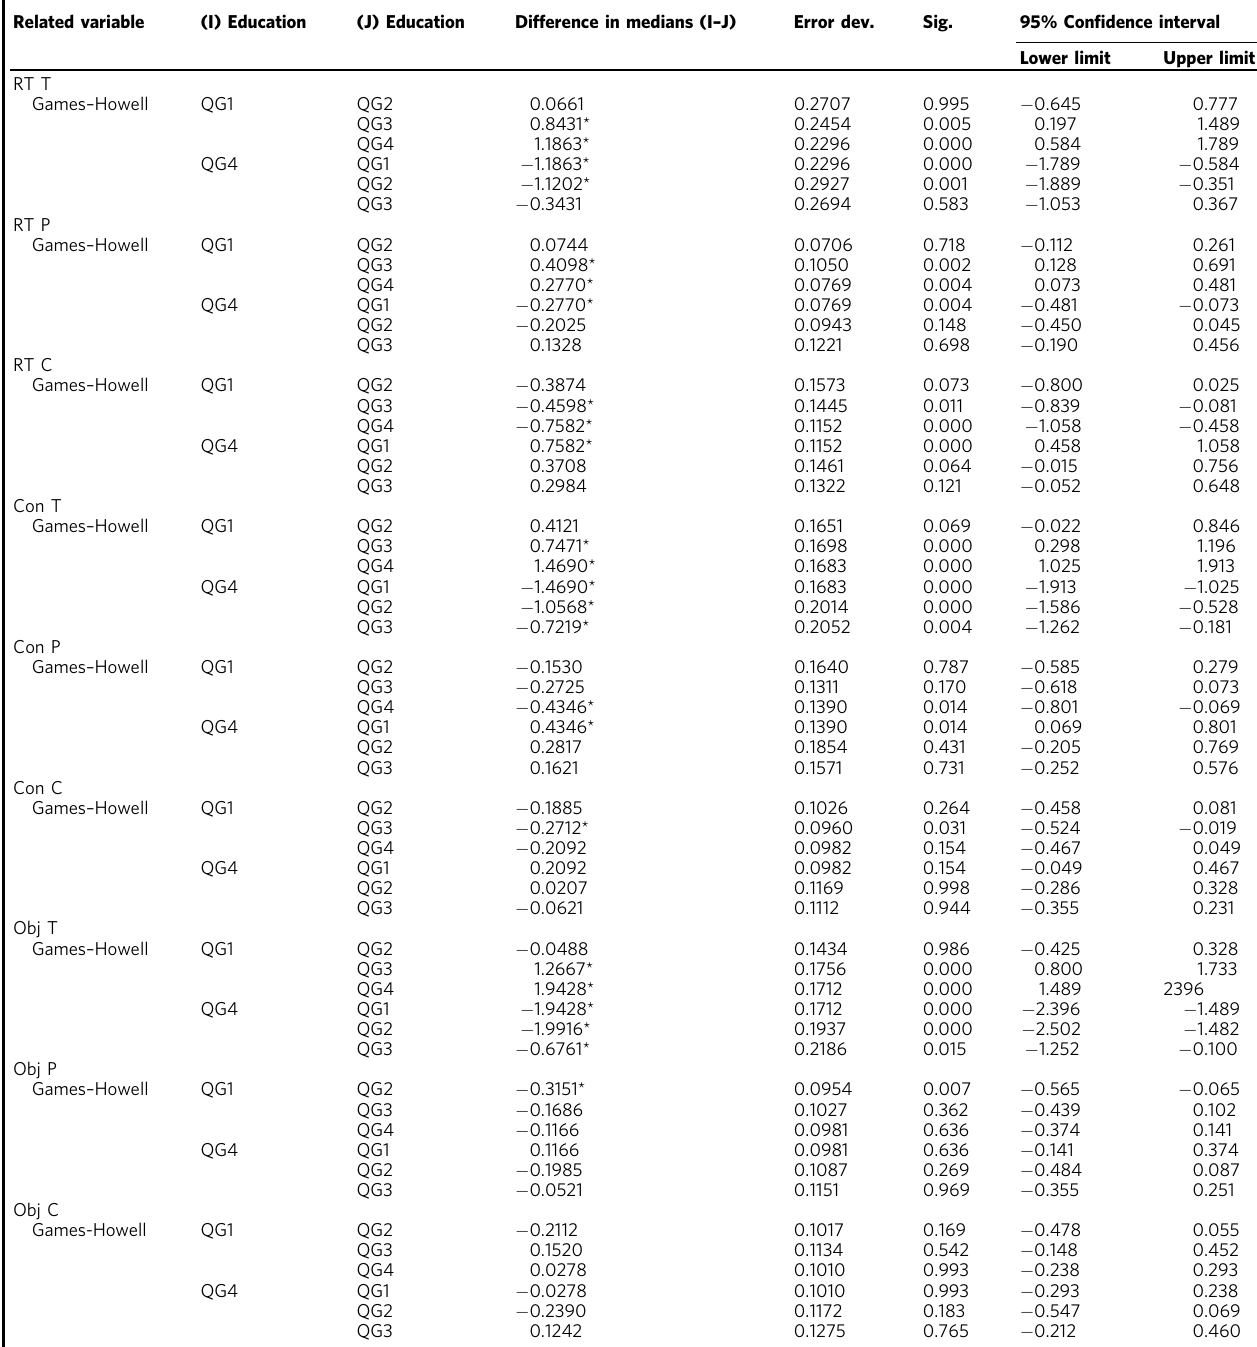
Table 8 Multiple comparisons between the different groups regarding the variable factor “ education ” (selection from comparisons with group 1 and group